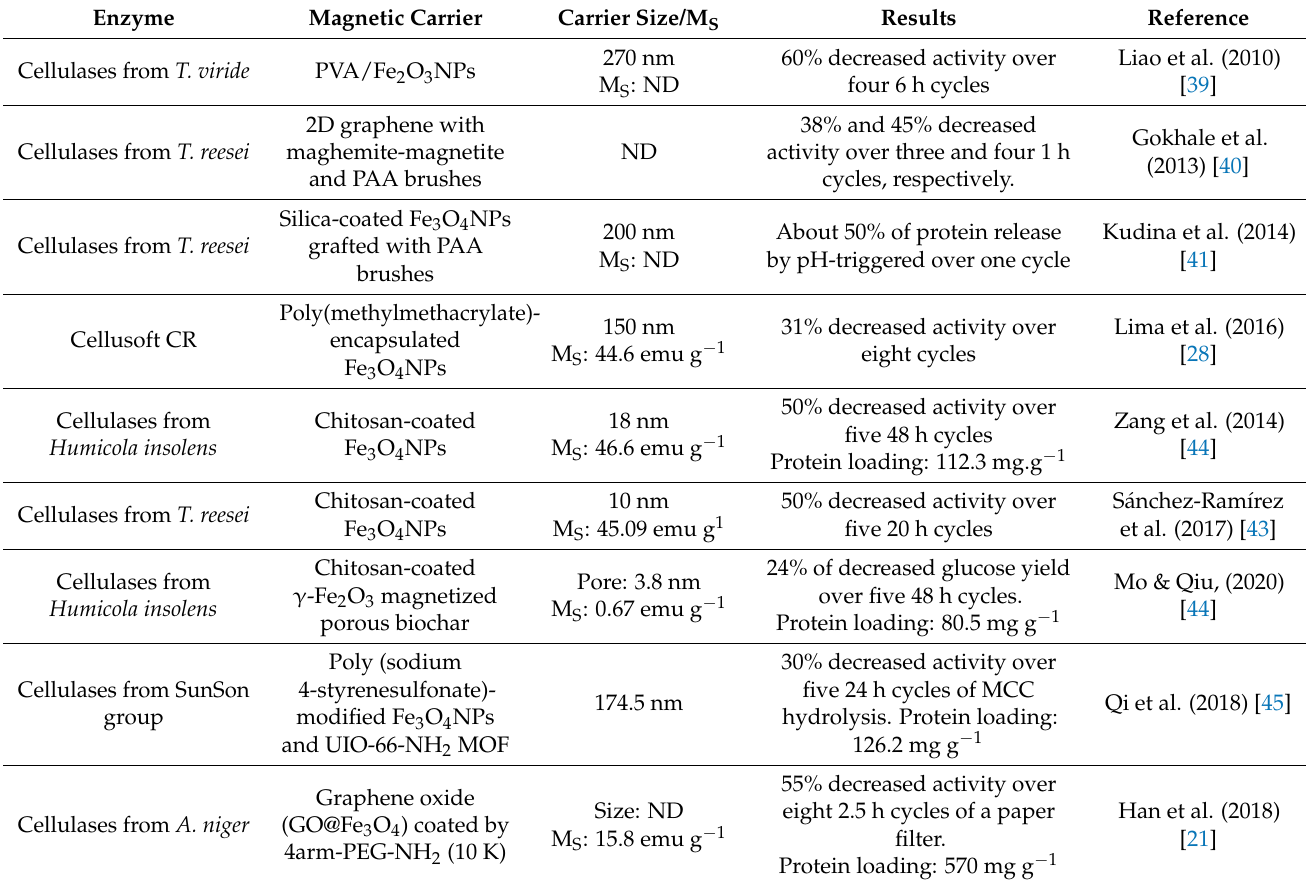
Table 2. Selected procedures of functionalized MNPs using cellulose-degrading enzymes and polymers. Enzyme Magnetic Carrier Carrier Size/M S Results